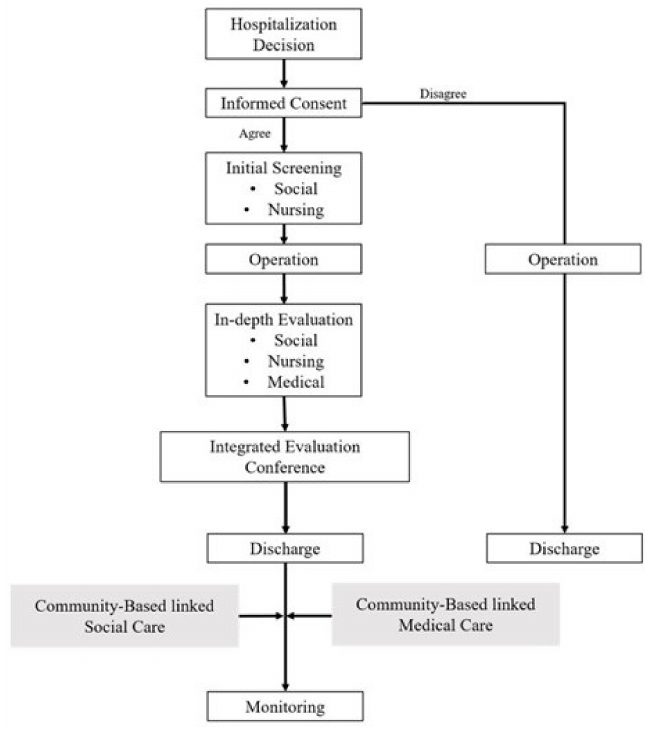
Figure 1. The overall process of the “discharge